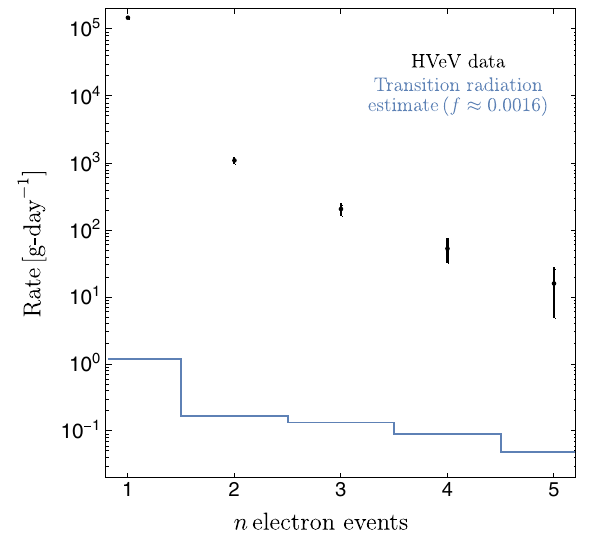
FIG. 22. The estimated n -electron event rate from transition radiation at SuperCDMS HVeV (blue line) based on a simple model with several assumptions and a photon detection proba- bility f ≈ 1 . 6 × 10 − 3 (see the text for details). The experimental data with 100 V bias voltage is shown in black with the error bars corresponding to the 3 σ statistical uncertainty